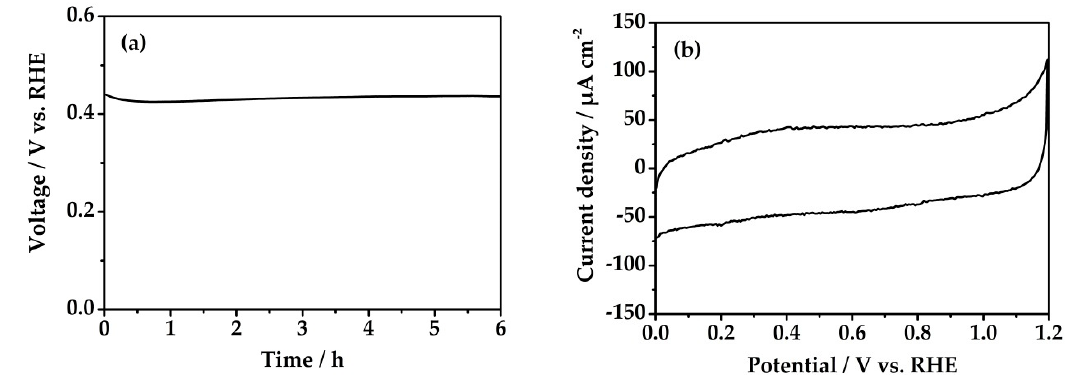
Figure 6. ( a ) Open circuit potential (OCP) and ( b ) CV after OCP and aging for 100 hours at 160 ◦ C in 15 M H 3 PO 4 with a scan rate of 20 mV s − 1 . Electrochemical measurements were done in 15 M H 3 PO 4 at room temperature.